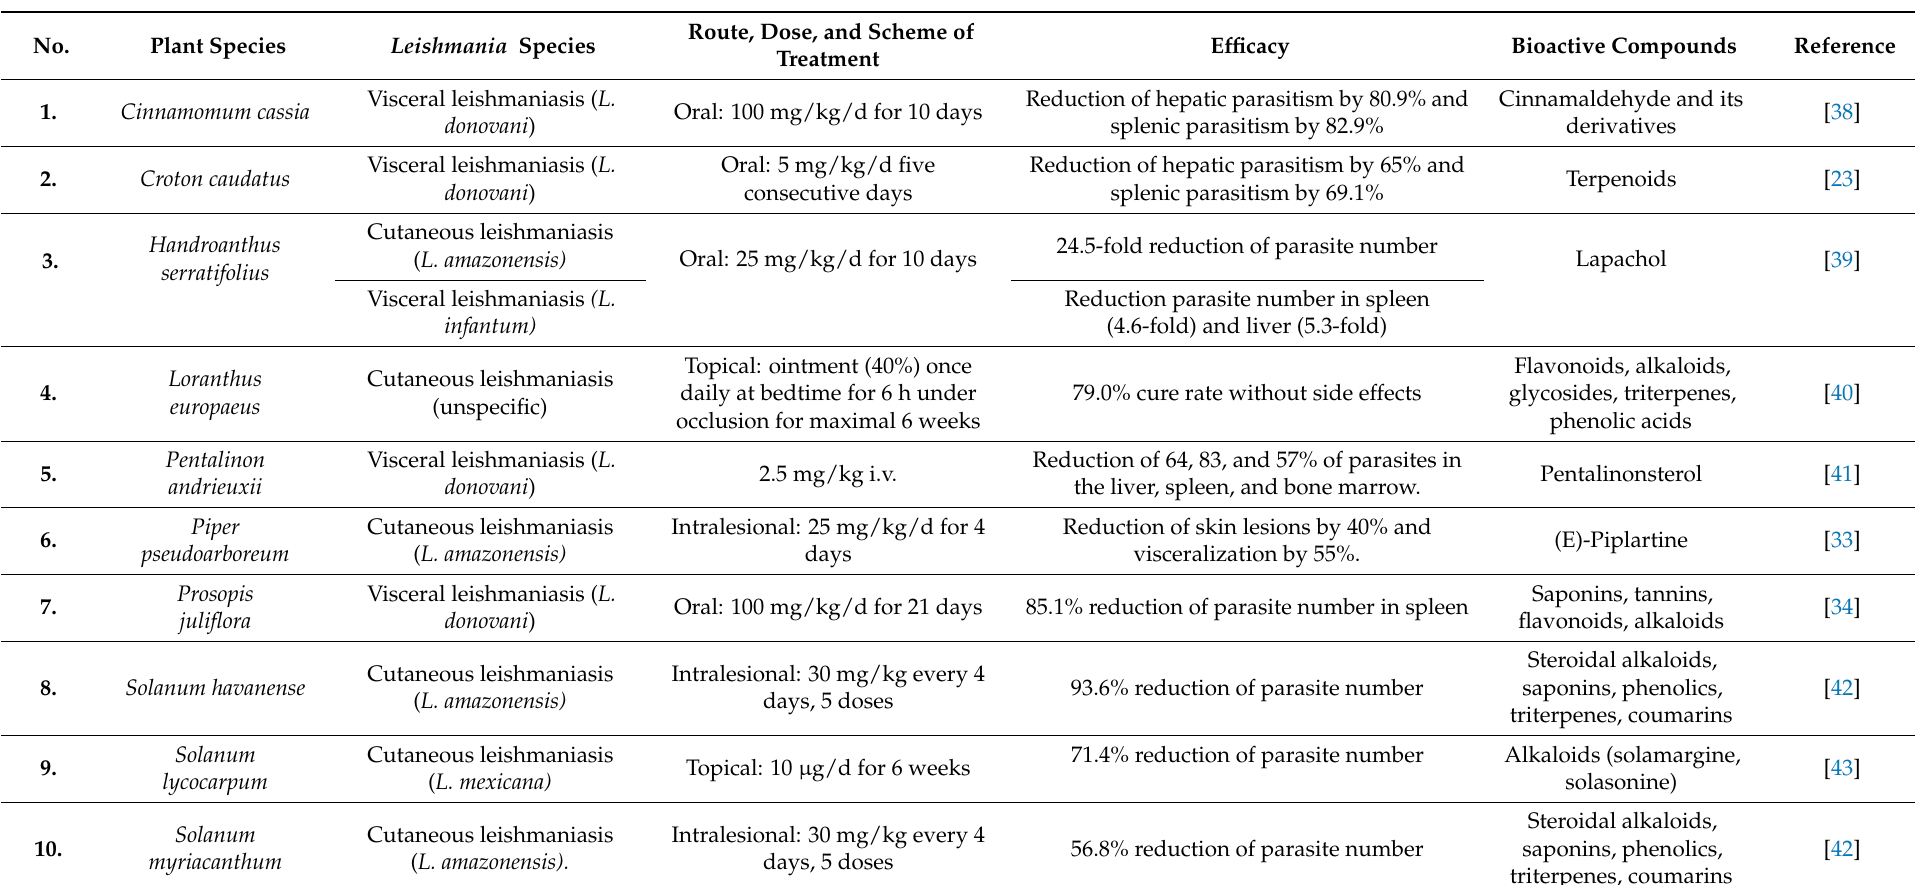
Table 4. Anti- Leishmania activity of medicinal plants in